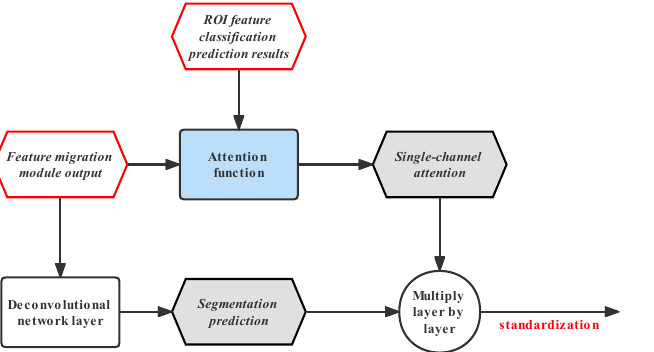
Figure 2. The structure of the migration optimization module based on category